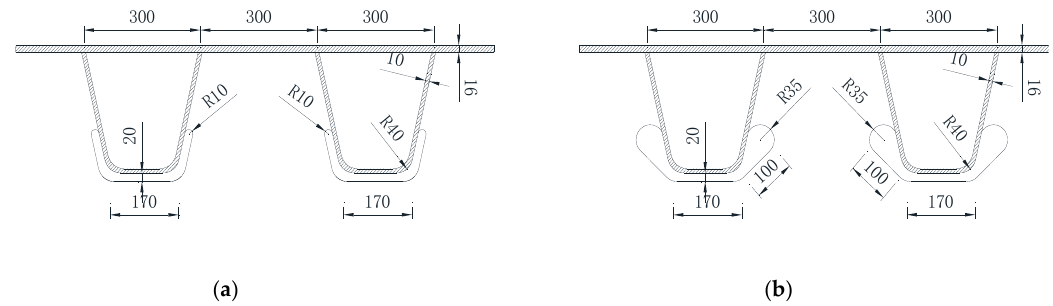
Figure 12. Geometry of ( a ) the original diaphragm cutout and ( b ) the retrofitted diaphragm cutout.